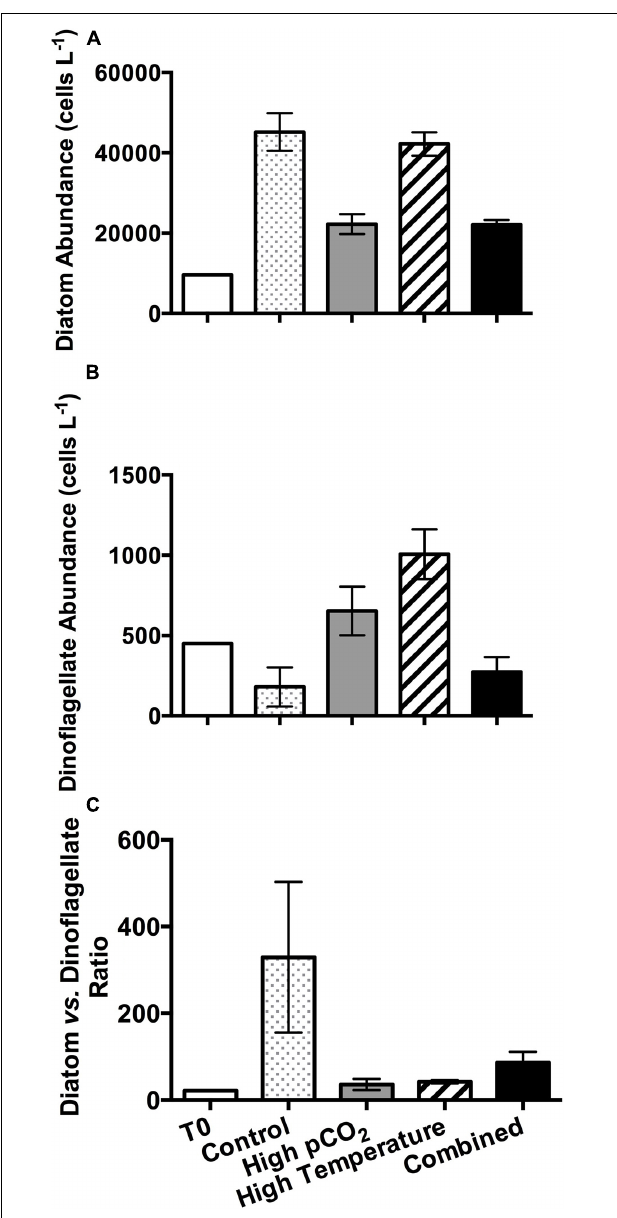
FIGURE 3 | Cell abundances of (A) diatoms and (B) dinoflagellates and (C) ratio of diatom to dinoflagellate abundances in the beginning of the incubation (T0) and in the four experimental treatments on the final sampling day. Values are the means and error bars are the standard deviations of